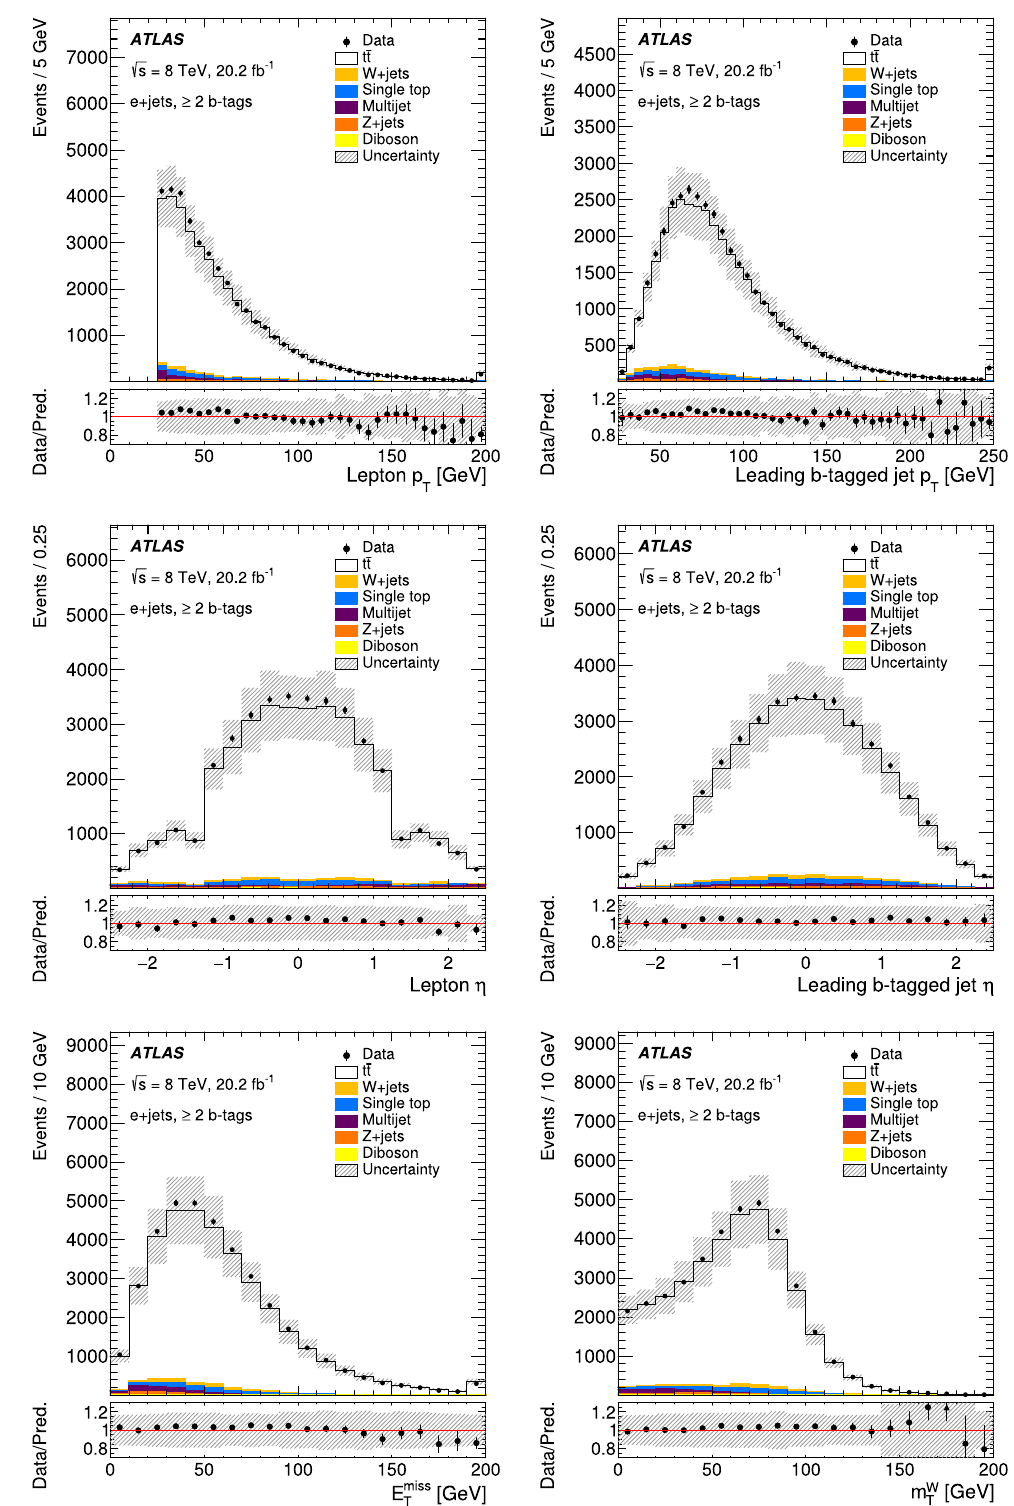
Fig. 1 Distributions of the lepton and leading b -tagged jet p T , lepton bands show the normalisation uncertainty in the signal and background andleading b -taggedjet η , E miss contributions and the signal model systematic uncertainties. The first and m W intheelectron+jetschannelfor T T events with at least two b -tagged jets after event selection. The hatched and last bins contain underflow and overflow events,